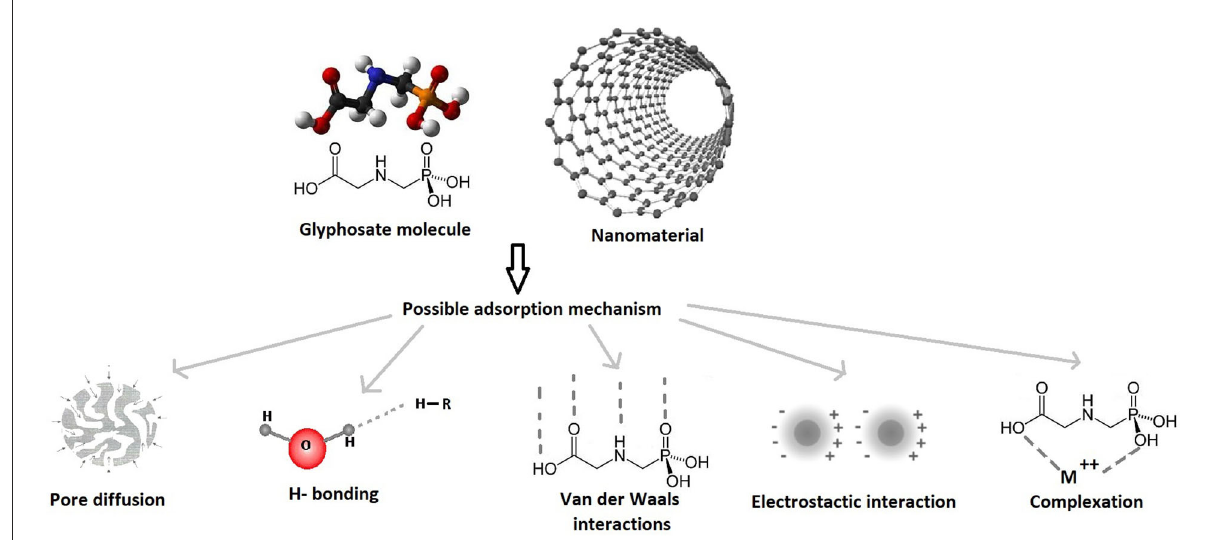
FIGURE1 Proposed mechanisms of glyphosate adsorption on